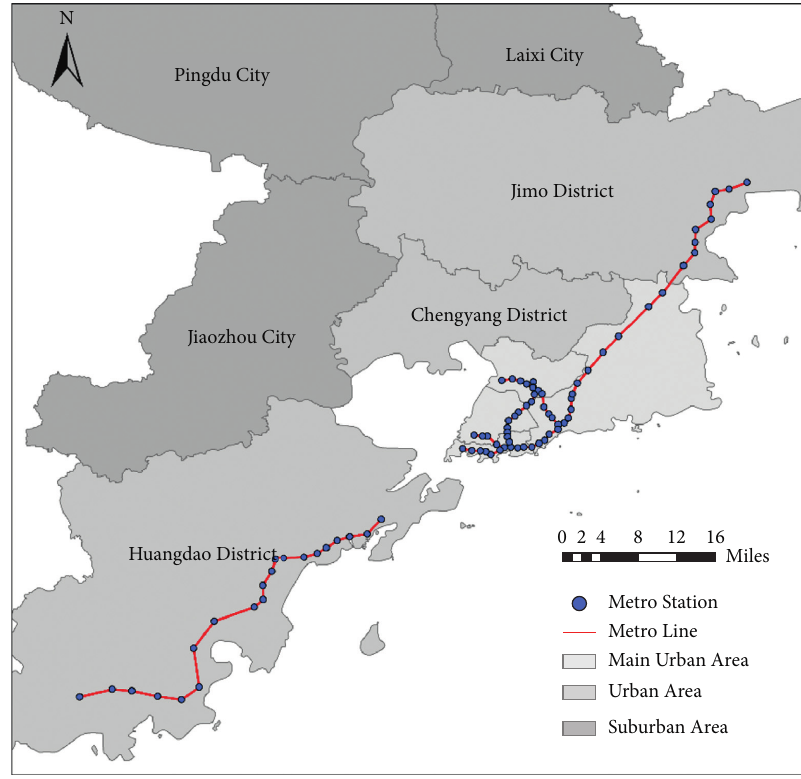
Figure 1: The metro network of